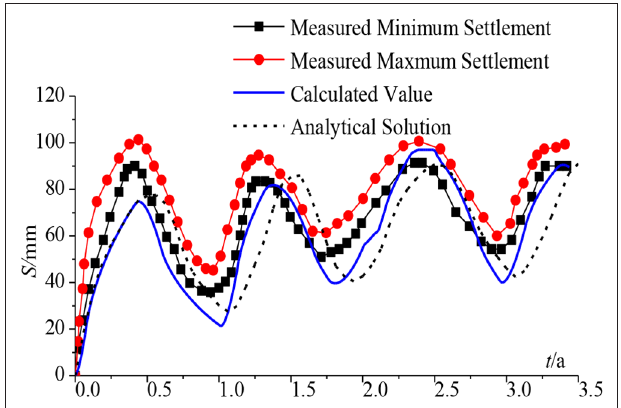
FIGURE 3 | Schematic diagram of meshing by the difference method.